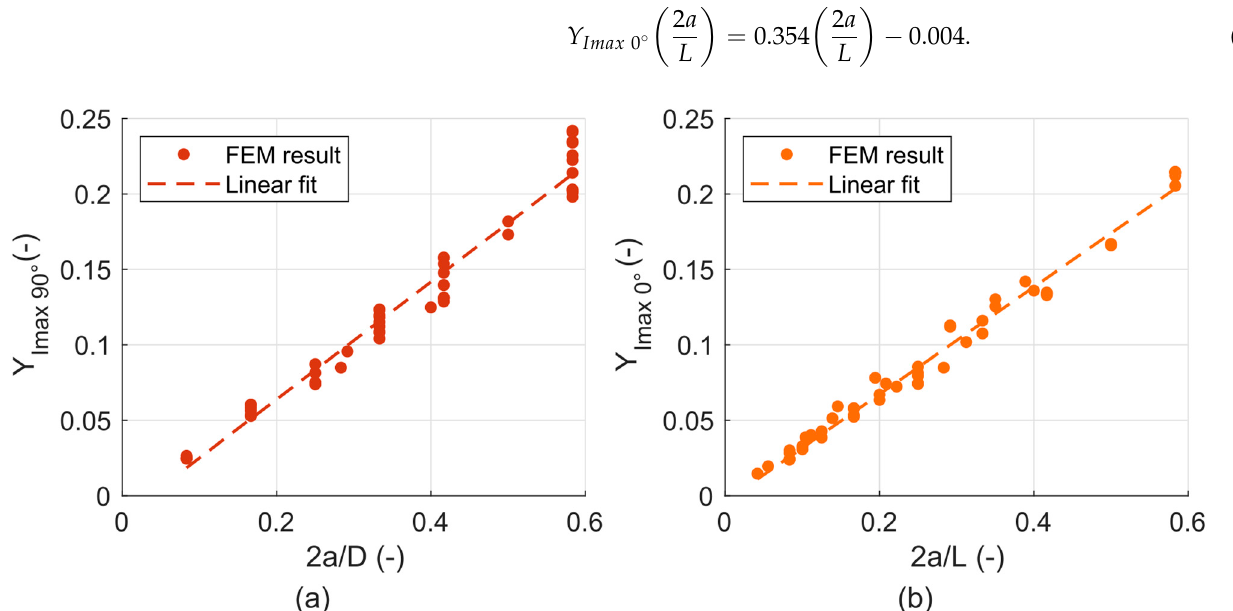
Figure 11. ( a ) Parametric functions fitting the values of Y Imax 90° ; ( b ) Parametric functions fitting the values of Y Imax 0° .